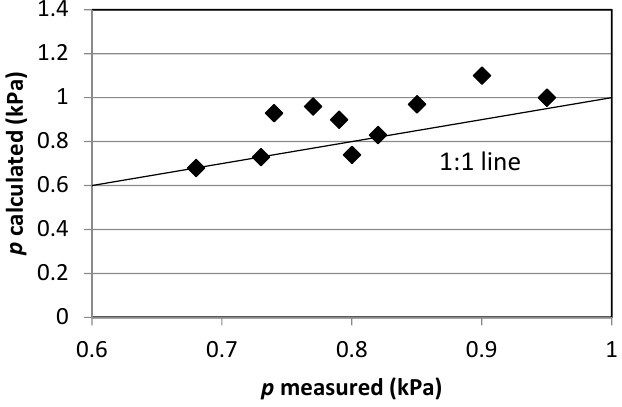
Figure 5. Maximum pore pressure measured during flume tests in relation to calculated pore pressures.